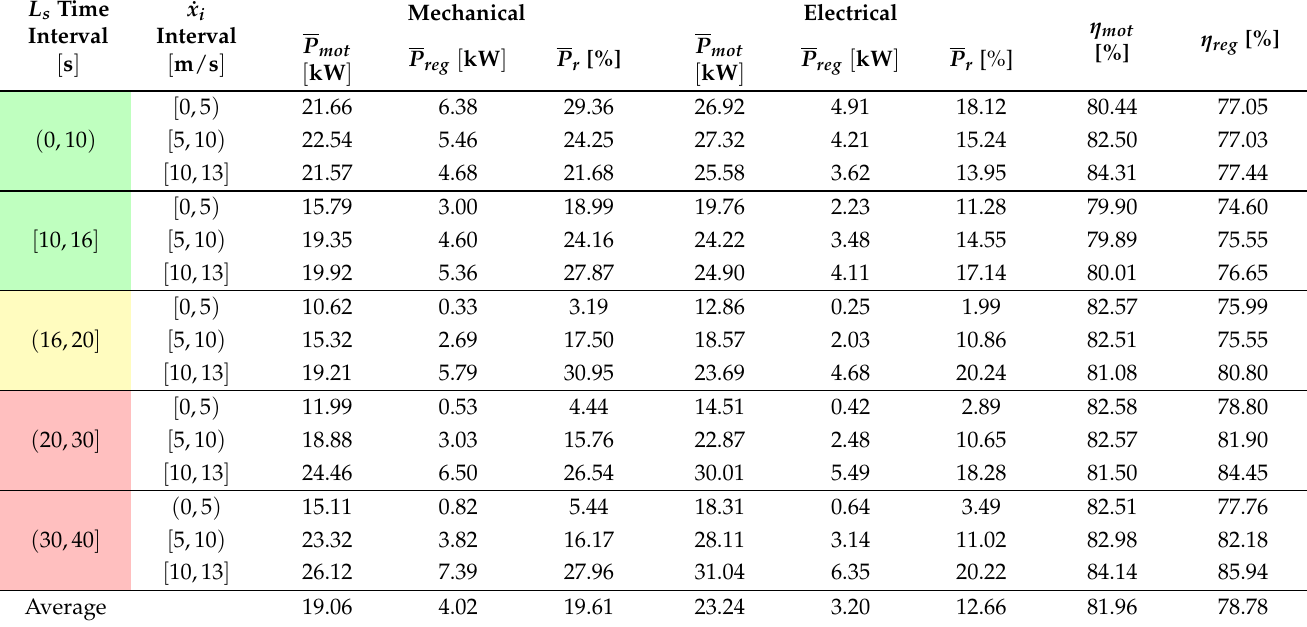
Table 5. Rule-based controller power performance.